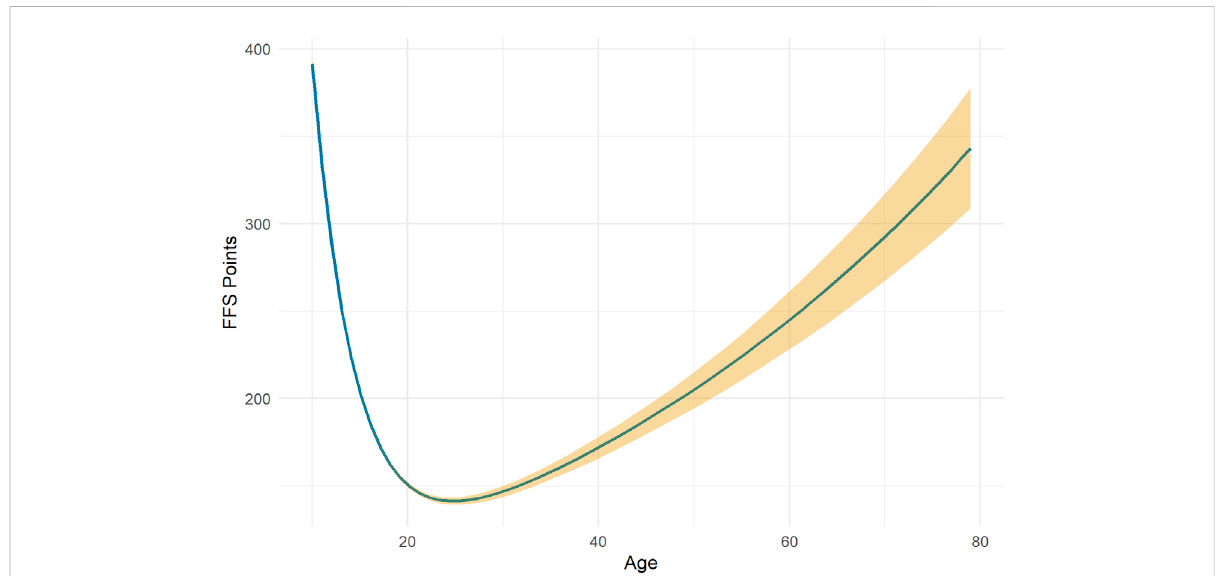
FIGURE 2 Moore ’ s age-performance relationship from a population perspective in men ’ s Giant slalom. The blue curve represents the median of the estimates, and the yellow area represents the quantiles of the estimates of order 0.025 and